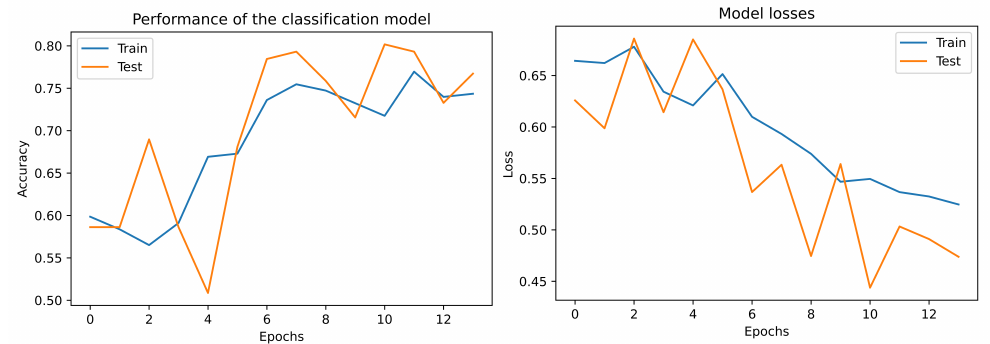
Figure 4. Loss and accuracy over the train and test data in the 2D-convolutional neural network pro- posed.